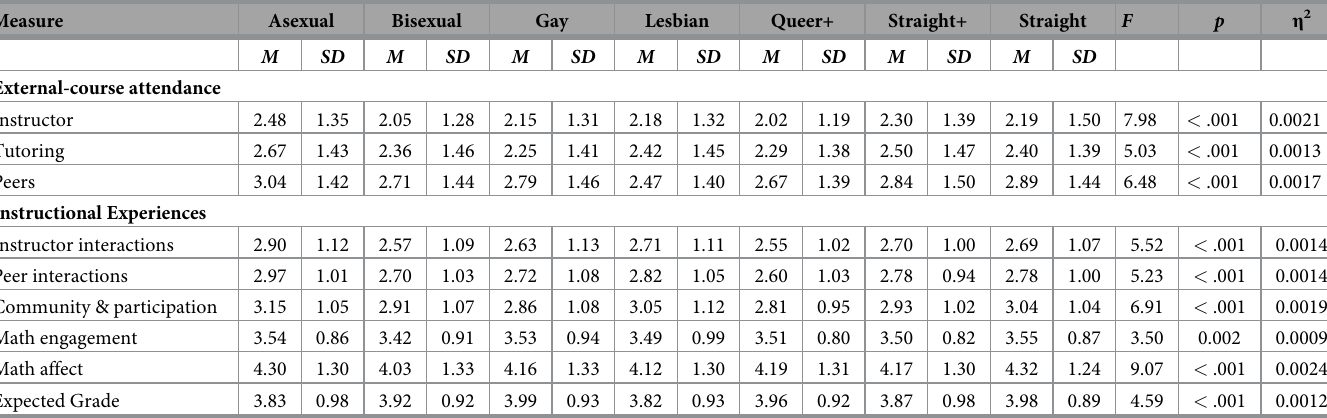
Table 4. Means, standard deviation, and one-way manova for external-course attendance, math instructional experiences, and sexual identity.